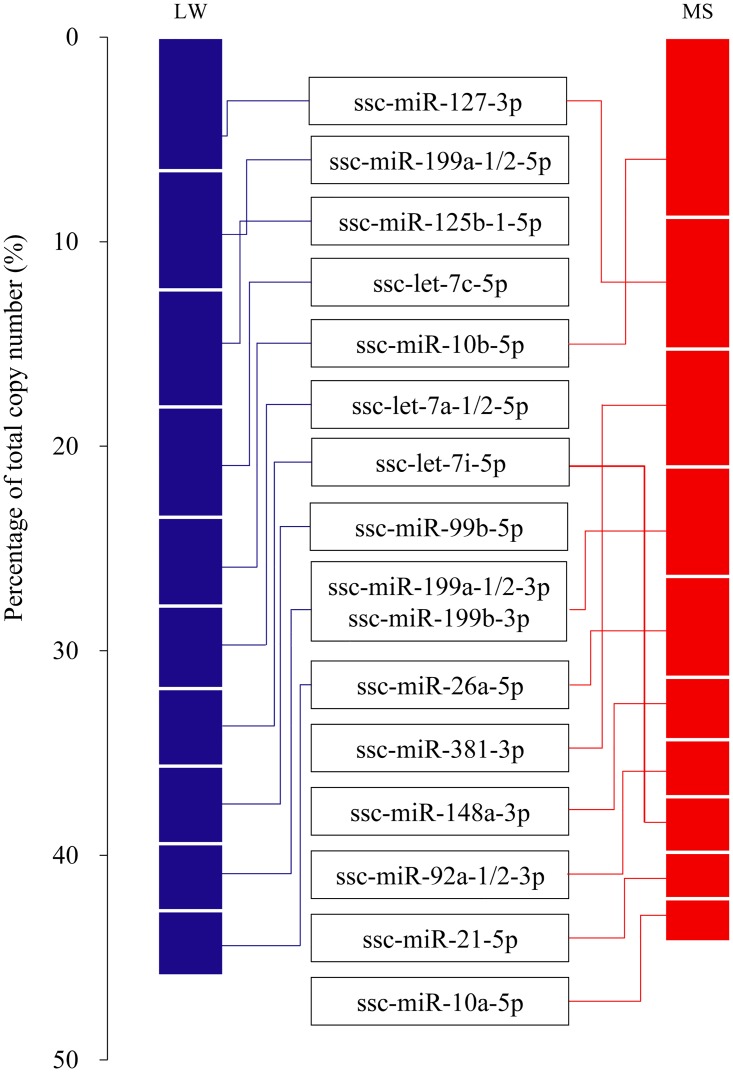
Top 10 unique miRNAs with the highest reads counts.